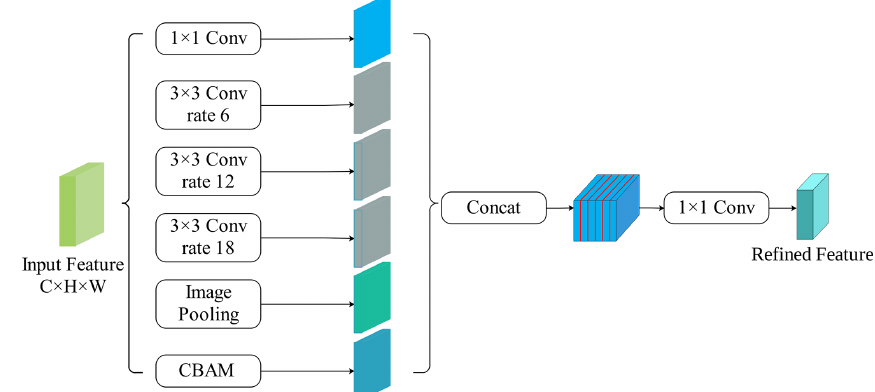
Figure 4. Structure of Attention ASPP.